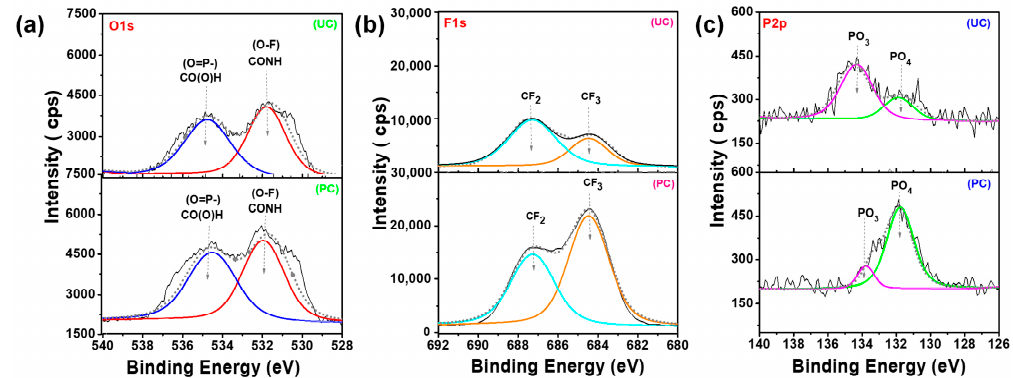
Figure 5. Deconvoluted XPS spectra of untreated phosphorus–fluoride coating UC and plasma-treated and phosphorus–fluoride coating PC on aramid fabric ( a ) O1s, ( b ) F1s, and ( c ) 2p, respectively.